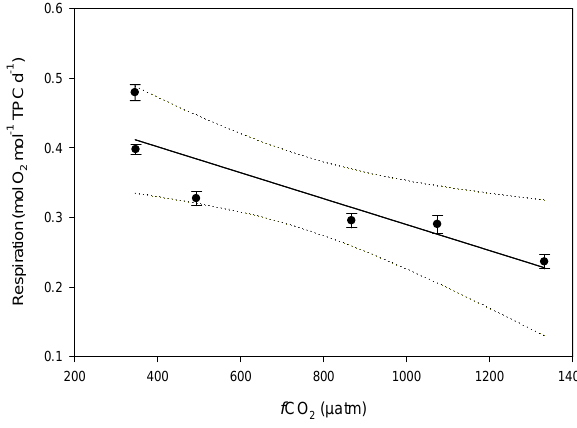
Fig 5 Figure 5. The cumulative respiration in the different f CO ments normalized to TPC. The f CO 2 (µatm) was the average mea- sured over the duration of the experiment. The two lowest f CO 2 treatments (346 and 348µatm) were controls without any CO 2 ad- dition. The two phases of the experiment are indicated by the hori- zontal bars on top.